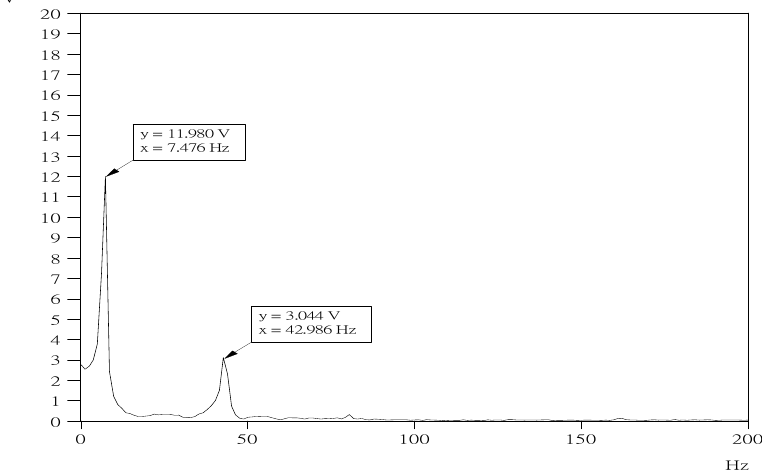
Figure 13. Frequency responses of the cantilever beam (x: frequency; y: amplitude).